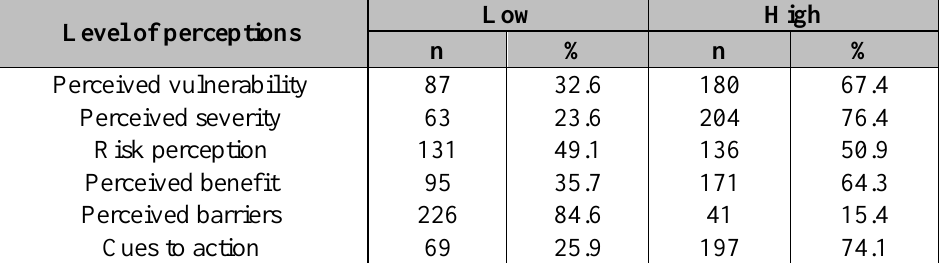
Table 4. Classification of participants’ perceptions in the context of a heat wave scenario based on the HBM and using the cut-off